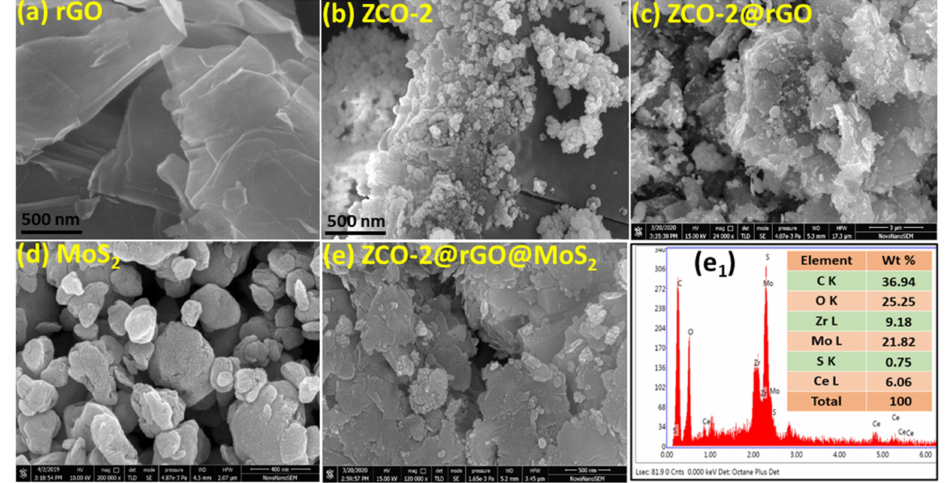
Figure 2. High resolution scanning electron microscopy (HR-SEM) images of ( a ) rGO, ( b ) ZCO-2, ( c ) ZCO-2@rGO, ( d ) MoS 2 and ( e ) ZCO-rGO@MoS 2 with its EDX spectrum ( e 1